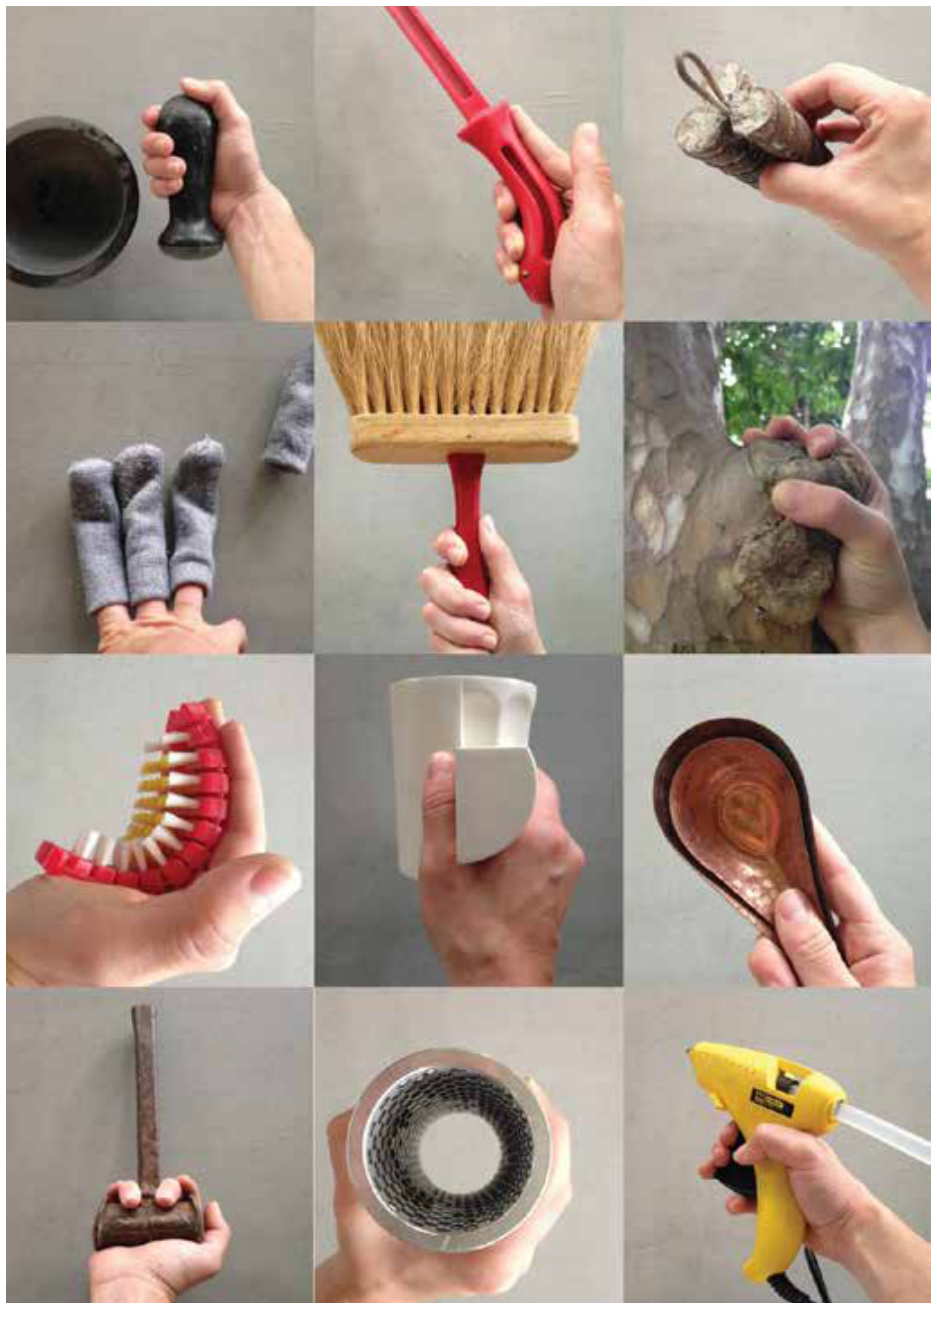
Figure 2: Holding things to see how they feel.